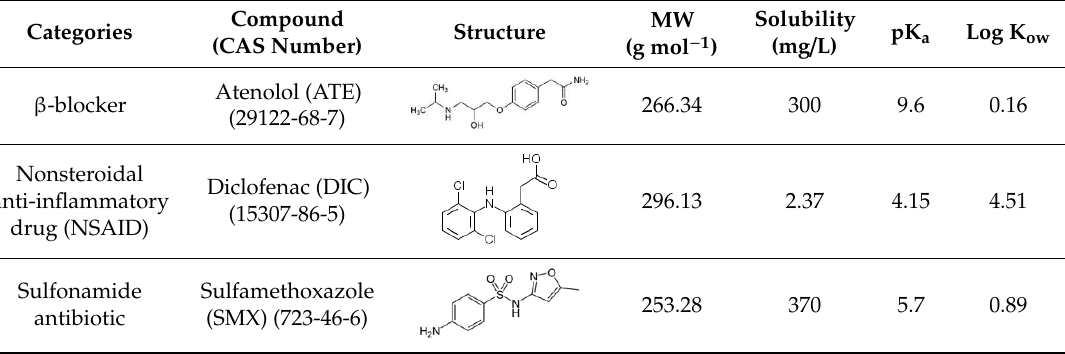
Table 1. Characteristics of the target compounds.